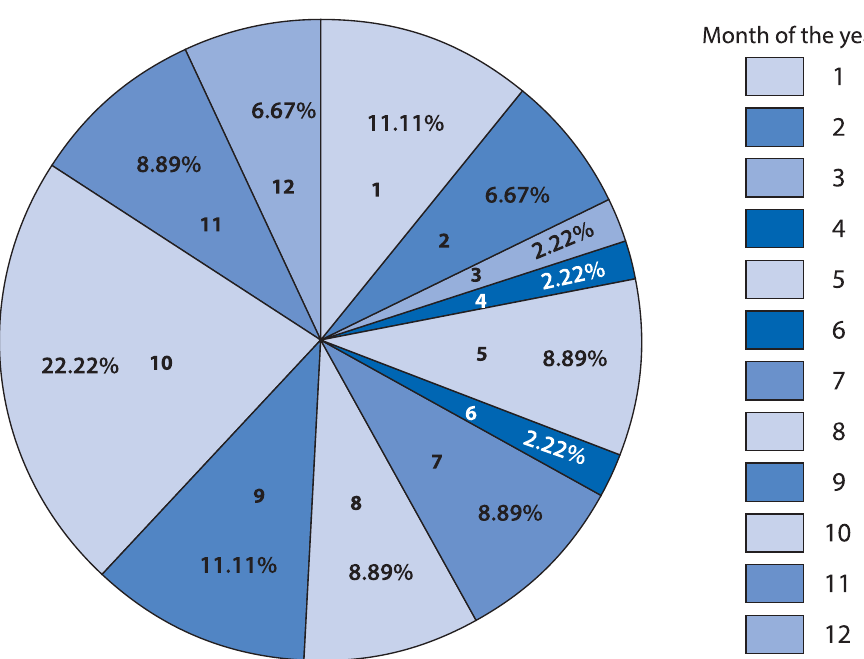
Figure 1: Distribution of cases of typhoid perforation according to month: January = 1 (5); February = 2 (3); March = 3 (1); April = 4 (1); May = 5 (4); June = 6 (1); July = 7 (4); August = 8 (4); September = 9 (5); October = 10 (10); November = 11 (4); December= 12